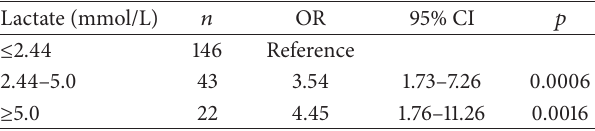
Table 3: Lactate categorised in three groups, OR for 30-day